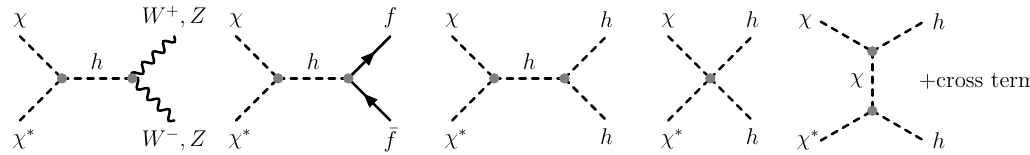
Figure 9 . The Feynman diagrams for the DM annihilation to SM.